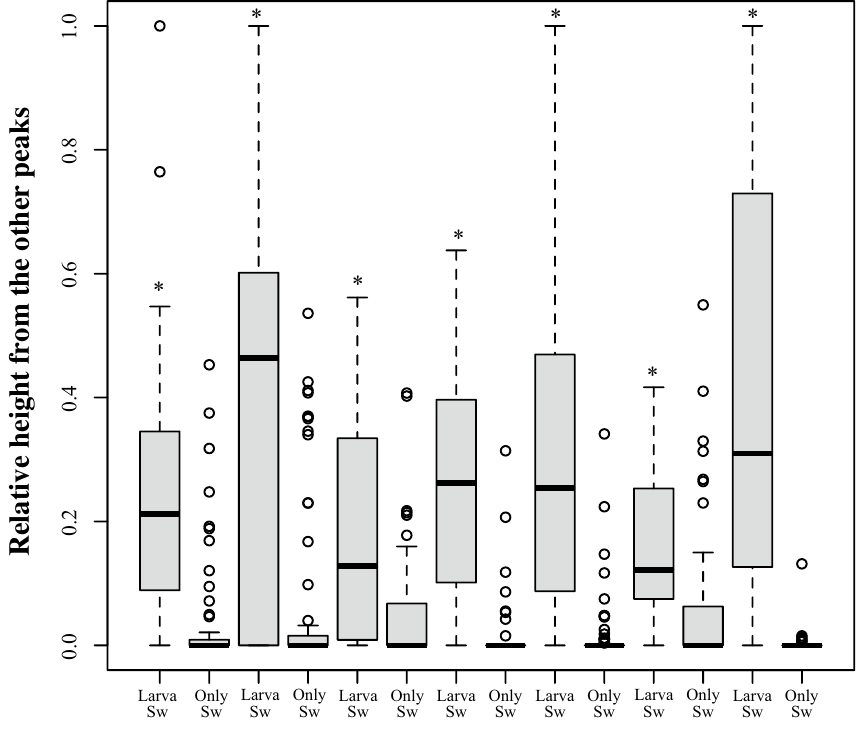
Figure 3. Fragment peaks of alleles. The fragment peaks for each MS marker were compared. Alleles found in sperm/fertilized eggs (Larva/SW) or only in sperm (only SW) are plotted. *P < 0.0001 (Welch t-test, M4 t = 3.95, df = 91.8, M5 t = 4.88, df = 30.5, M7 t = 4.89, df = 47.9, M8 t = 8.39, df = 69.5, M9 t = 7.52, df = 45.0, M12 t = 3.22, df = 85.0, M13 t = 7.71, df =